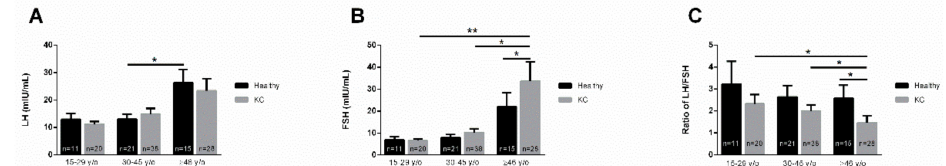
Figure 3. Age-dependent expression of LH and FSH, and the LH / FSH ratio, in healthy and KC blood (plasma) samples. Three age groups were investigated: Healthy 15–29 y / o (n = 11), KC 15–29 y / o (n = 20), Healthy 30–45 y / o (n = 21), KC 30–45 y / o (n = 38), Healthy ≥ 46 y / o (n = 15) and KC ≥ 46 y / o (n = 28). ( A ) LH levels in healthy controls and KCs, per age group, ( B ) FSH levels in healthy controls and KCs, per age group, and ( C ) the LH / FSH ratio in healthy controls and KCs, per age group. * p < 0.05, ** p < 0.01. (See Supplementary Materials—Figure